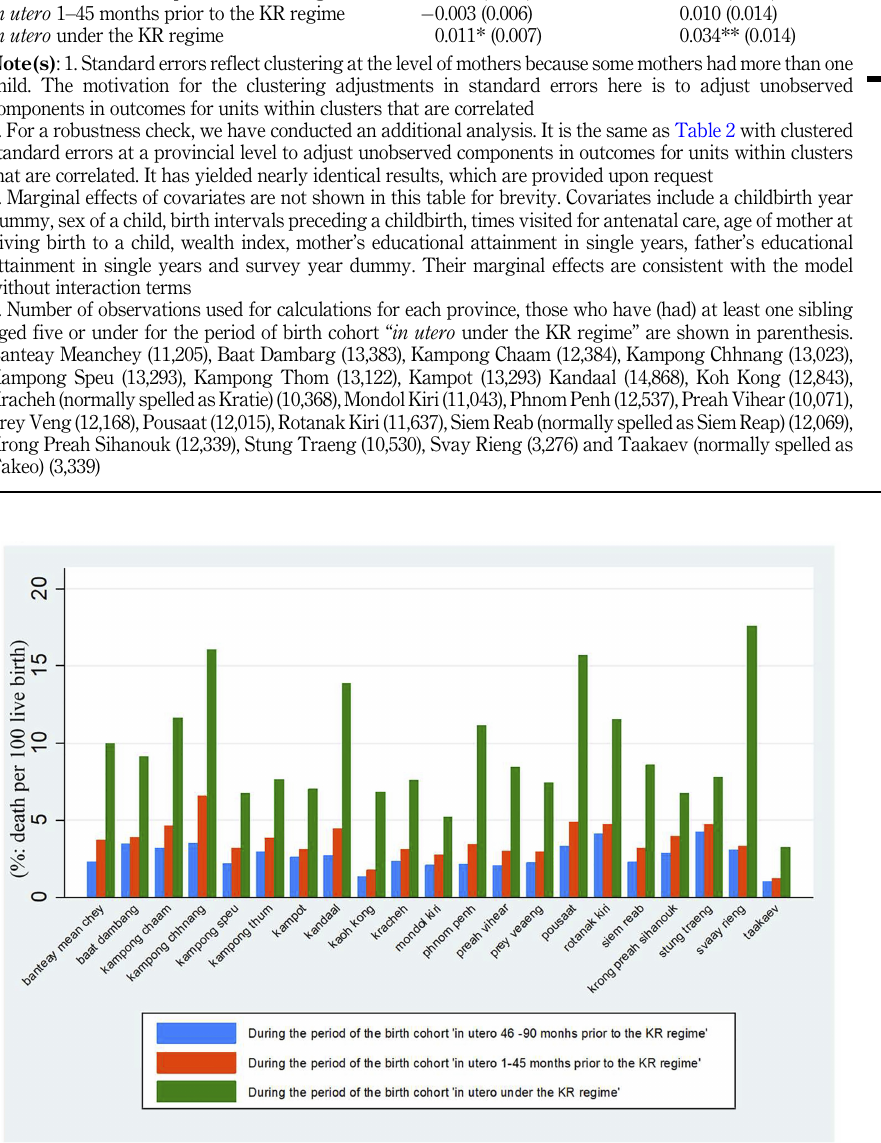
Figure 1. Provincial